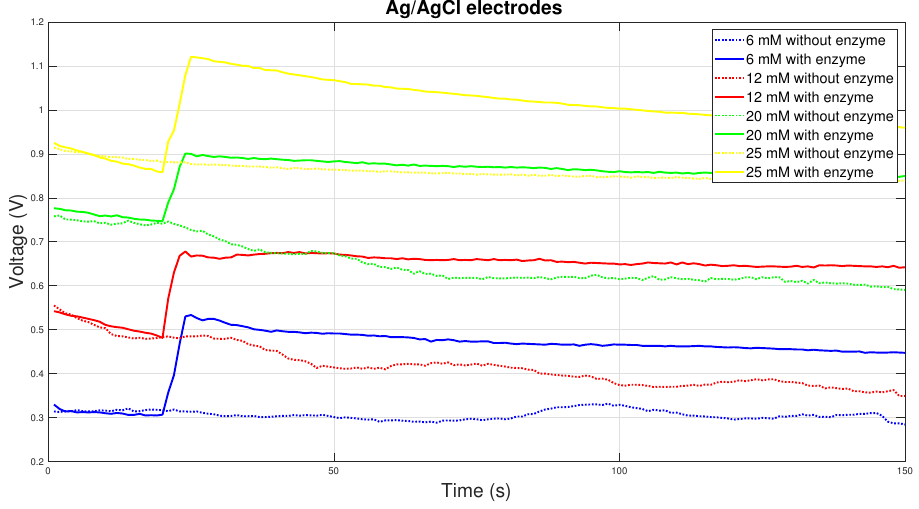
Figure 8. Voltage comparison between Ag/AgCl